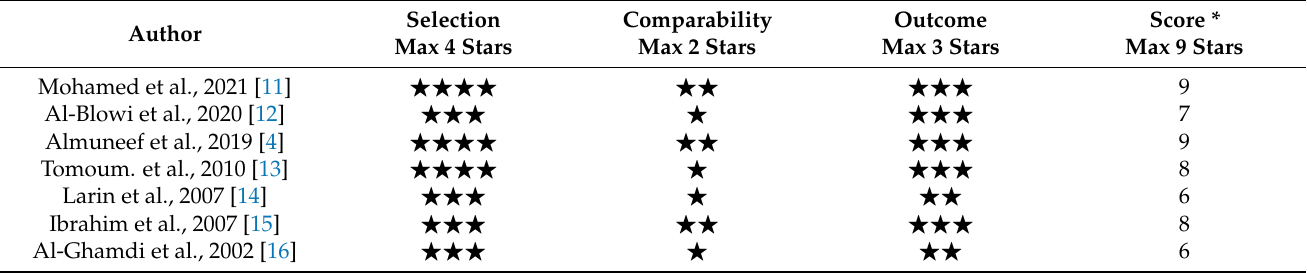
Table 2. Newcastle-Ottawa Scale (NOS) scores for included